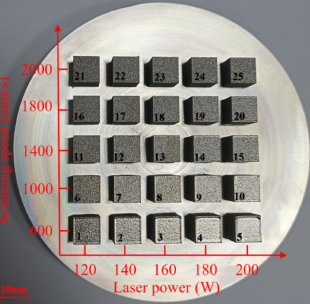
Figure 2. Appearance of 25 samples under different laser powers and scanning